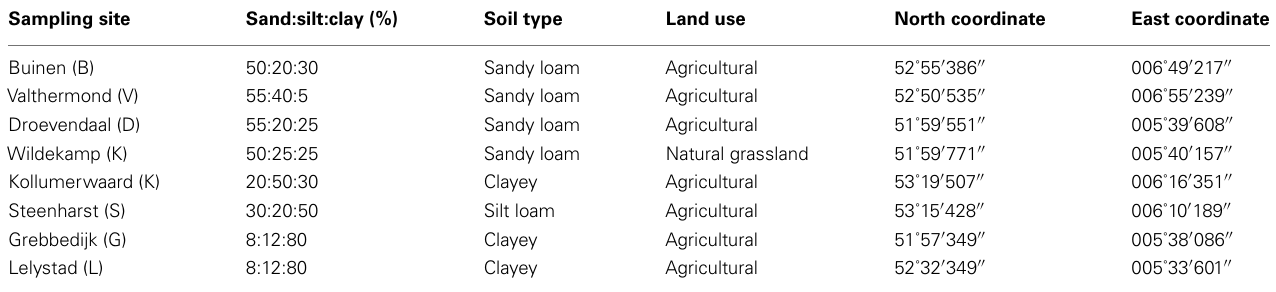
Table 1 | Specific data for each soil concerning soil type, land use as well as GPS coordinates. Sampling